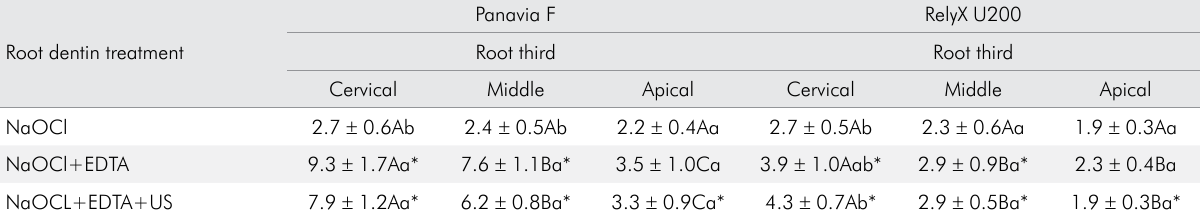
Table 1. Partial and total mean values over the standard deviation total (MPa) of BS as the root reinforcement treatment protocol for each sealer and root third of the